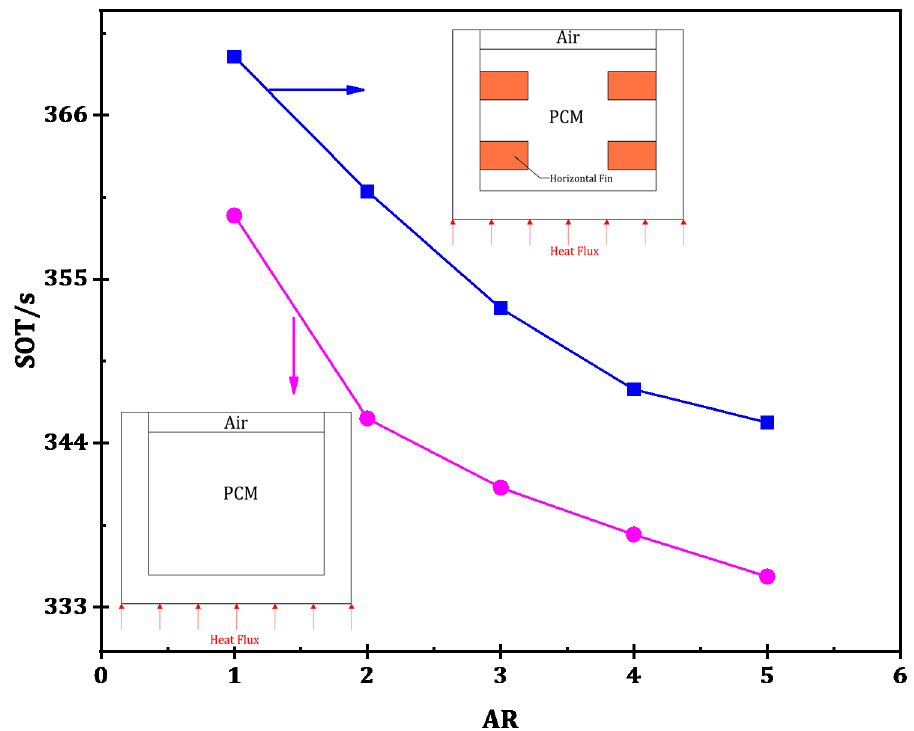
Figure 4. The variations in SOT owing to the incorporation of horizontal fins into the PCM filled heat sink.